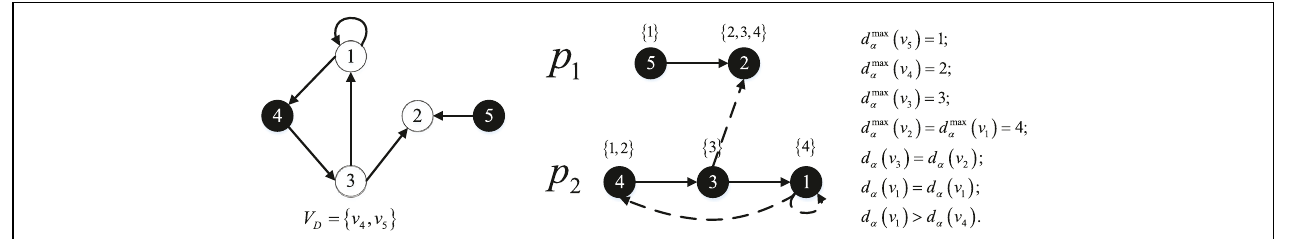
FIGURE 4 | The schematic diagram of successive integers’ distribution